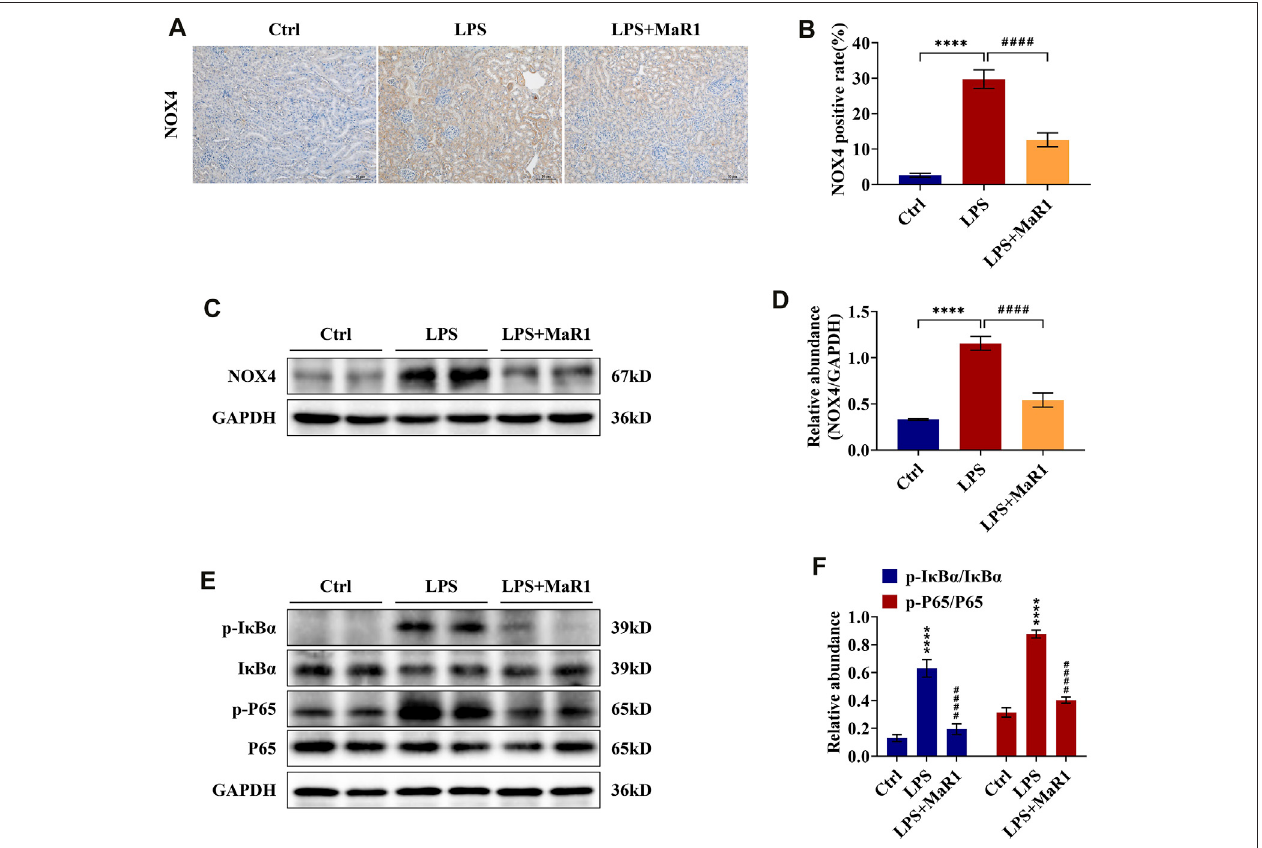
FIGURE 4 | MaR1 inhibited NOX4 expression and NF- κ B pathway activation in the kidneys of lipopolysaccharide (LPS)-induced S-AKI mice. (A) Representative immunohistochemistry images of NOX4 in renal sections were collected (scale bar (cid:2) 50 μ m). (B) Average optical density of NOX4. (C) The expression of NOX4 in renal tissues was analyzed using Western blot. (D) The protein level of NOX4 was quanti fi ed by densitometry and normalized with GAPDH. (E) The expressions of p-I κ B α , I κ B α , p-P65, and P65 in renal tissues were analyzed using Westernblot. (F) The protein levels ofp-I κ B α /I κ B α and p-P65/P65 were quanti fi ed by densitometry and normalizedwithGAPDH(timepoint:12 h).Dataarepresentedasmean ± SD, n (cid:2) 5.* p < 0.05,** p < 0.01,*** p < 0.001,**** p < 0.0001 vs .controlgroup;# p < 0.05,## p < 0.01, ### p < 0.001, #### p < 0.0001 vs . LPS